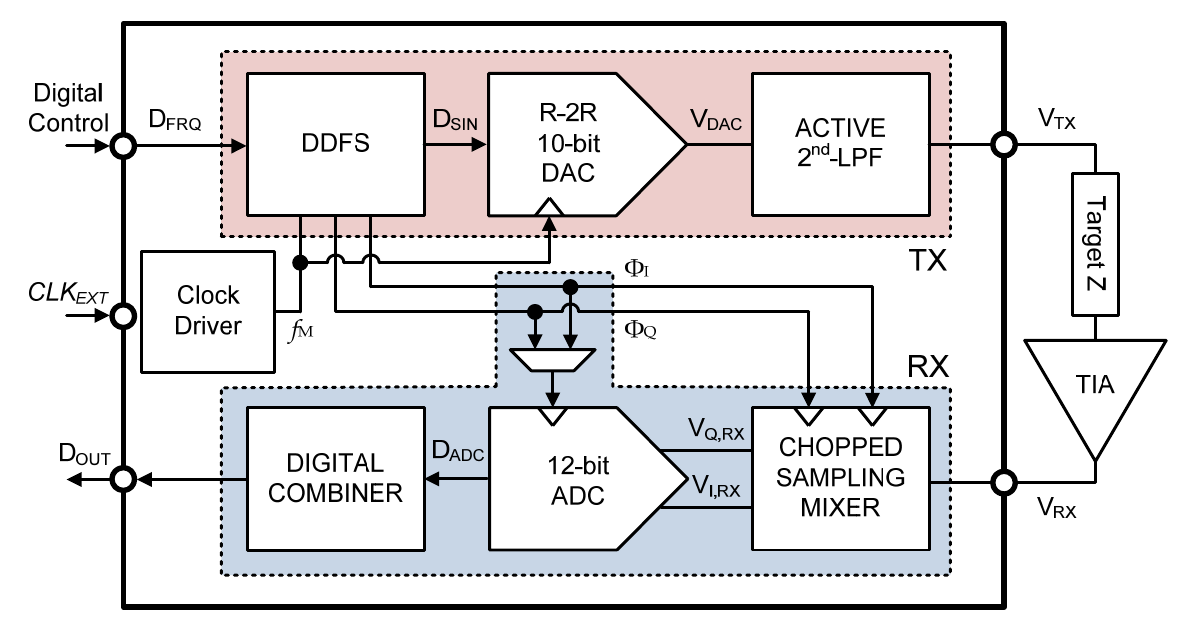
Figure 2. The block diagram of our EIS SoC.